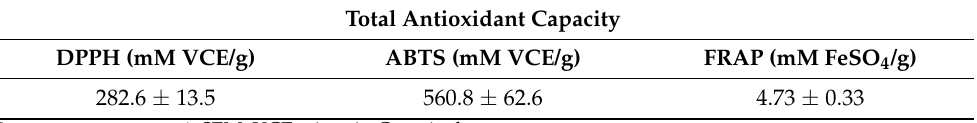
Table 1. Total antioxidant capacity of BE.